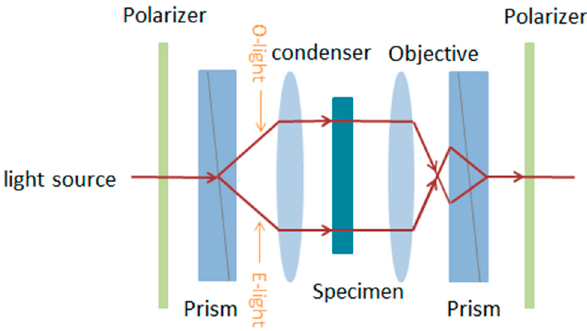
Figure 5. Sketch of the differential interference contrast (DIC) microscope.